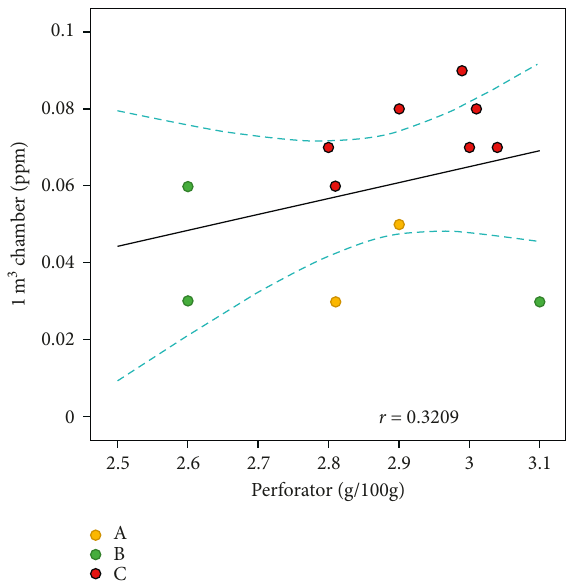
Figure 2: Correlation between 1 m 3 chamber (following ASTM D6007-14) formaldehyde emissions and ISO 12460-5 perforator formaldehyde content for 18mm particleboards of three types. Circles represent values measured from different production batches, and dotted lines represent confidence bands. No outliers exist. Upper and lower fences are 0.114 and